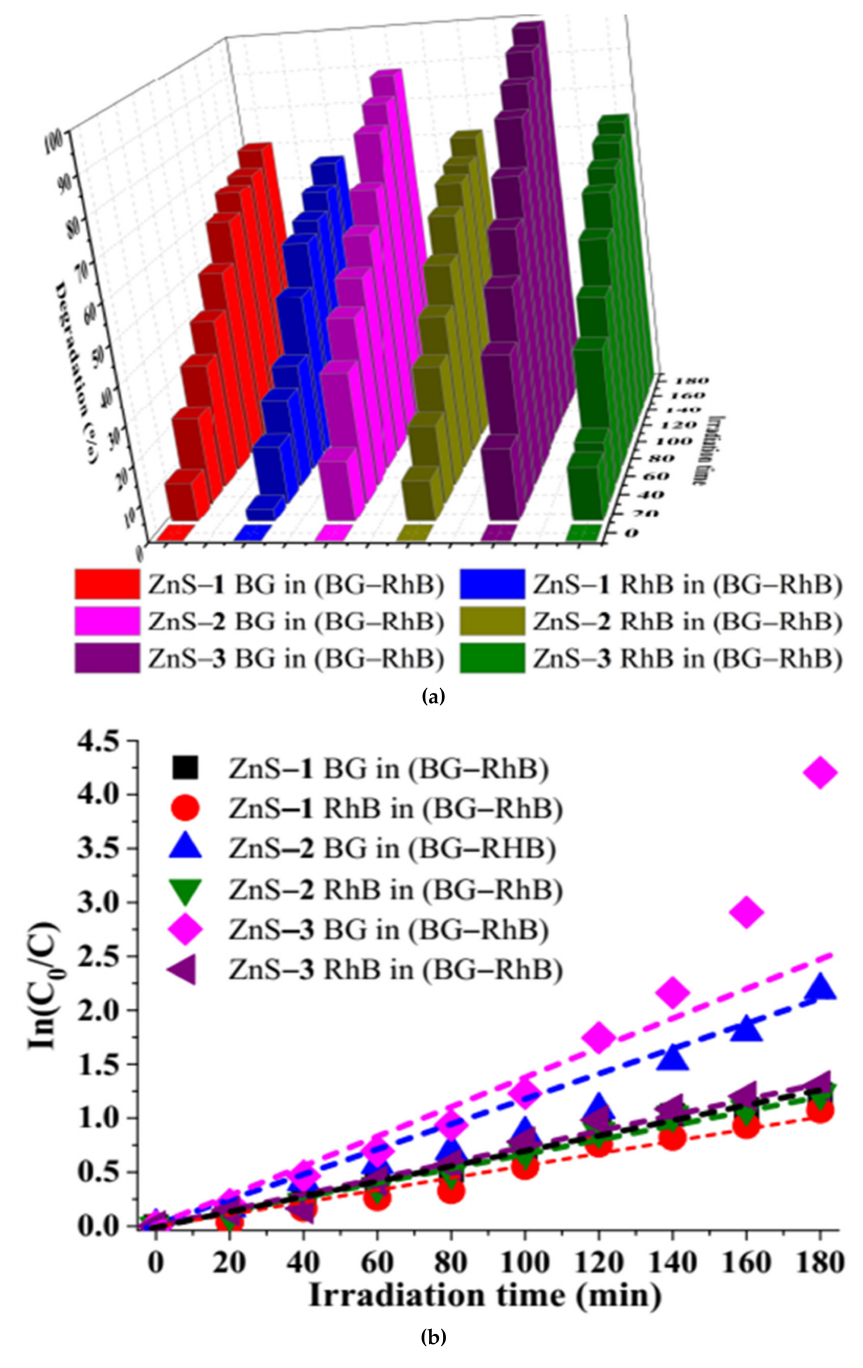
Figure 6. Degradation efficiency bar chart of binary dye by ZnS quantum dots ( a ), and corresponding kinetic studies plot ( b